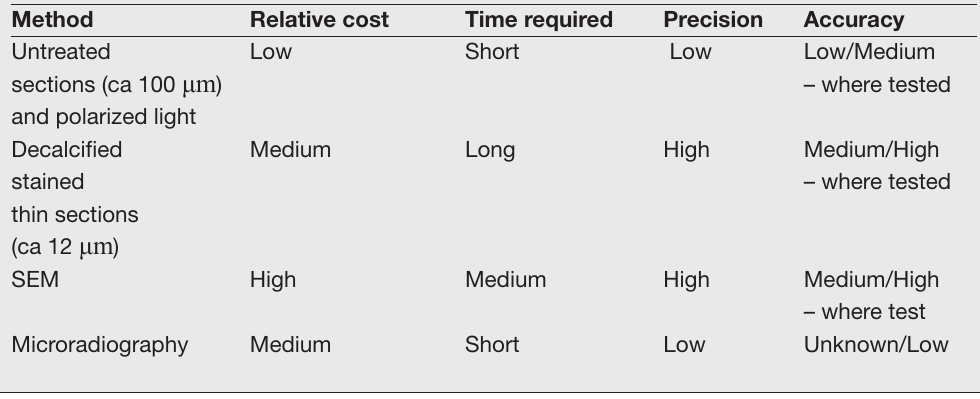
Table 1. Summary of cost and benefits of different tooth preparation methods in harbour